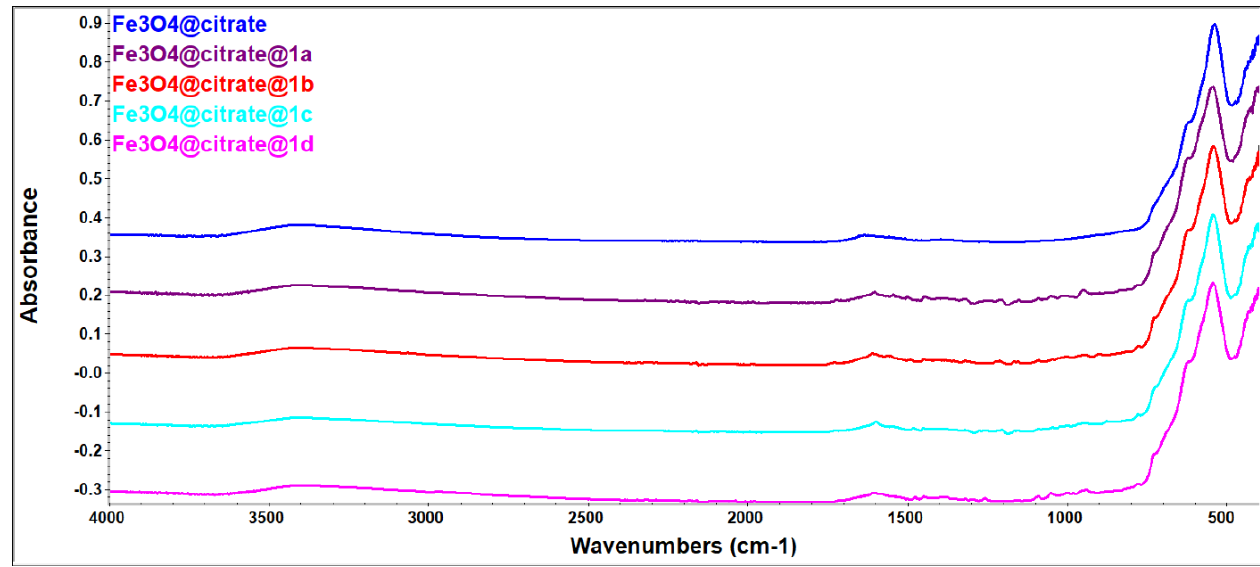
Figure 9. The FTIR spectra of magnetic samples loaded with fluorene derivatives.